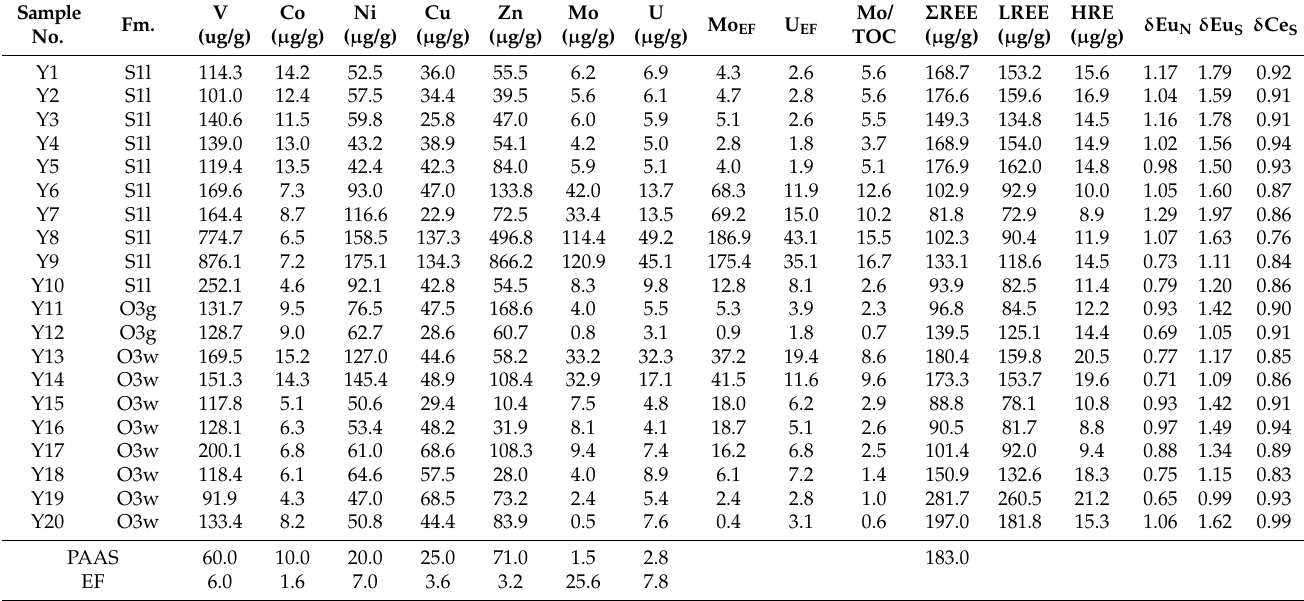
Table 2. Trace elements and REE and relevant parameters of CN outcrop. Sample